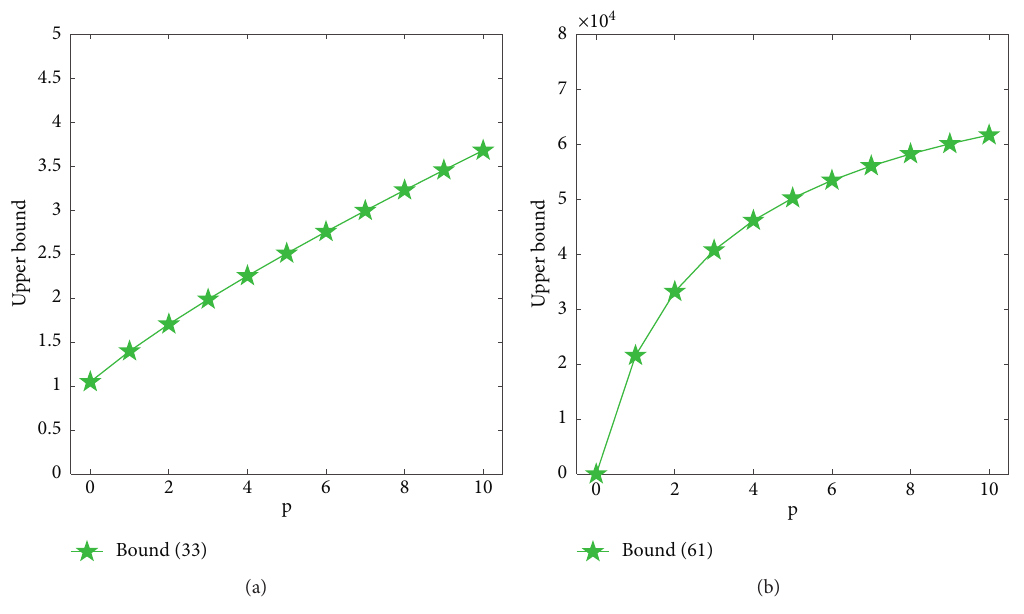
Figure 3: Bound (33) and bound (61) as a function of p